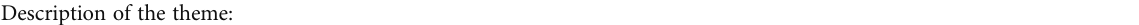
Table 4: Theme 3: role as a